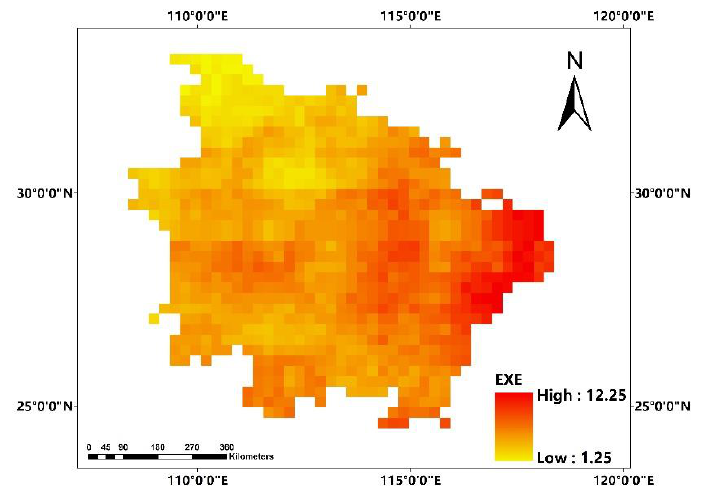
Figure 13. Frequency of extreme rainfall.